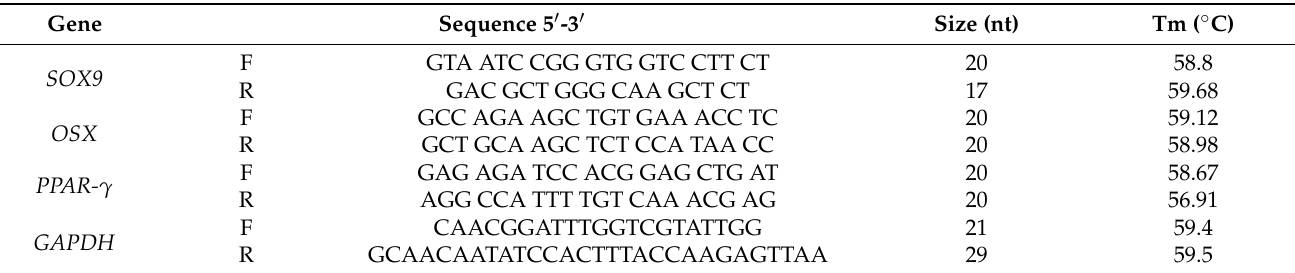
Table 1. Primer Sequences for